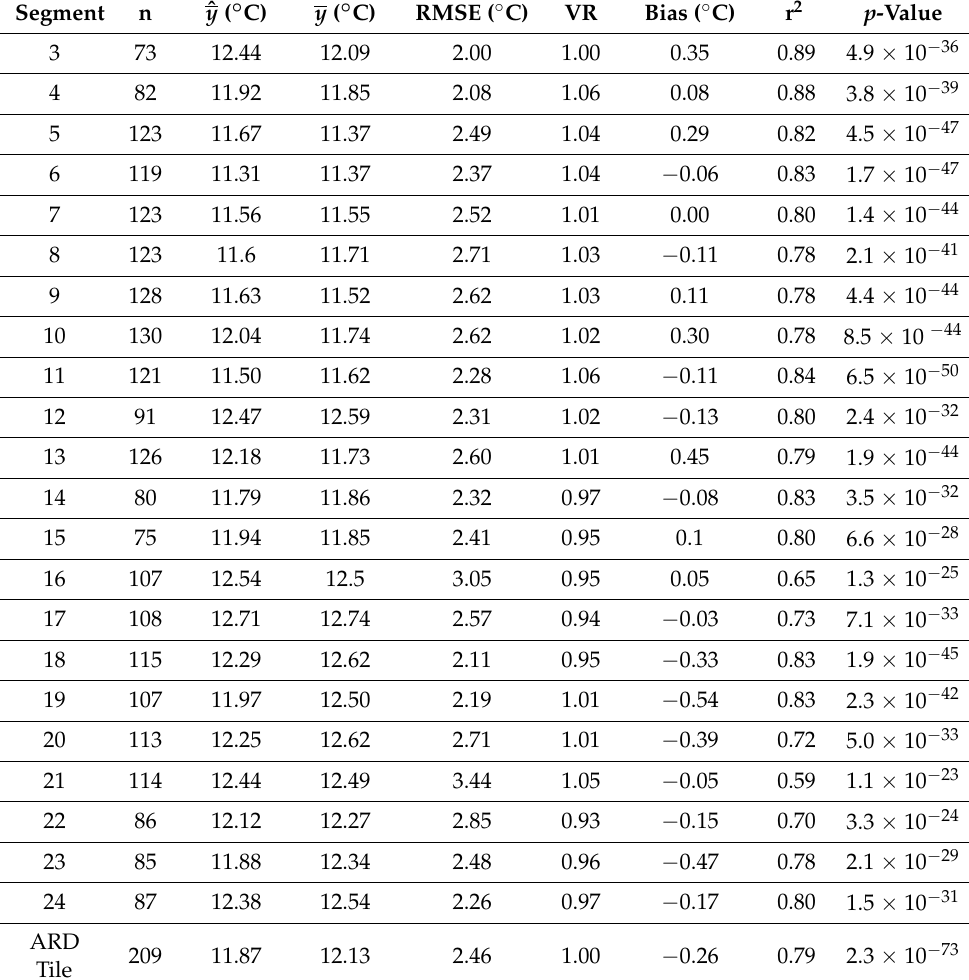
Table 2. Summary of agreement between river sections and USGS streamgage